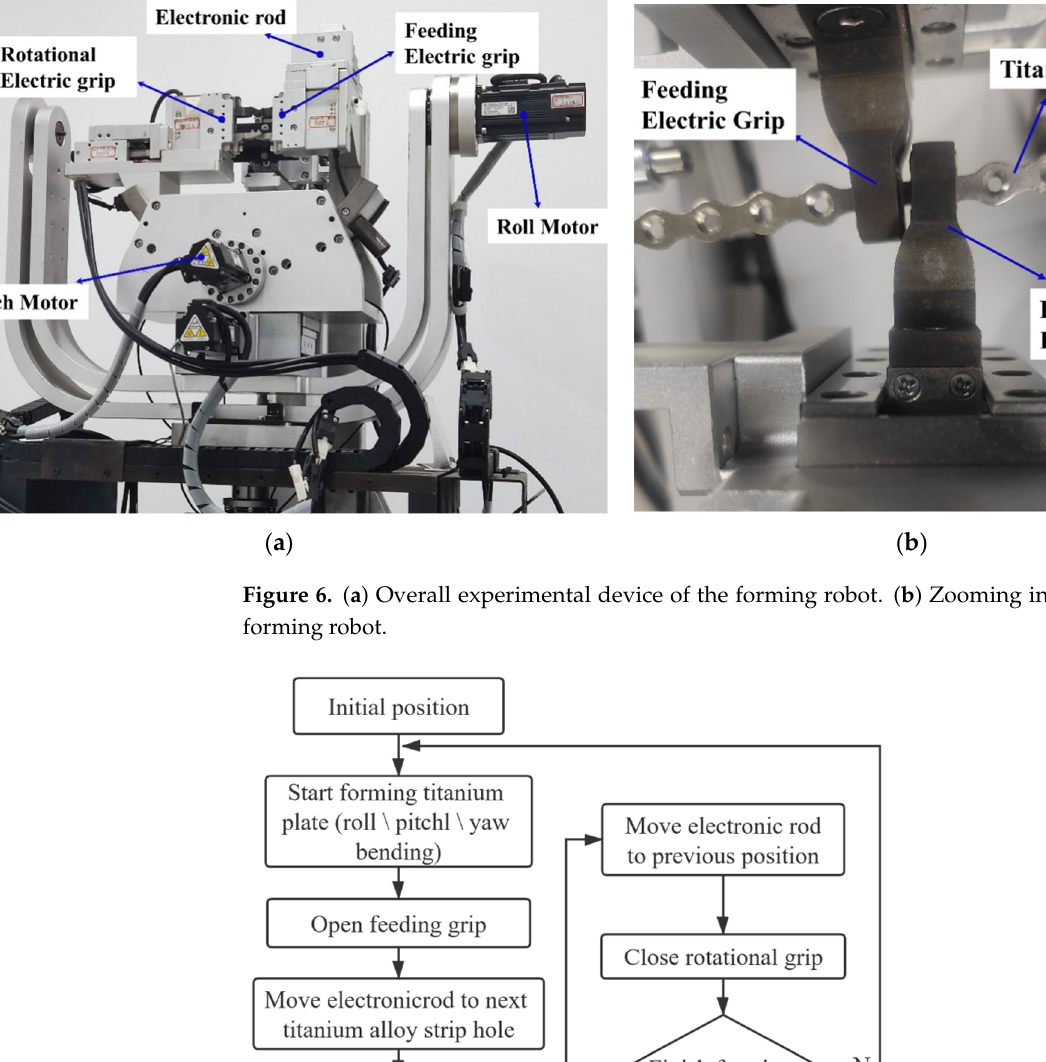
Figure 7. The flowchart of the forming robot